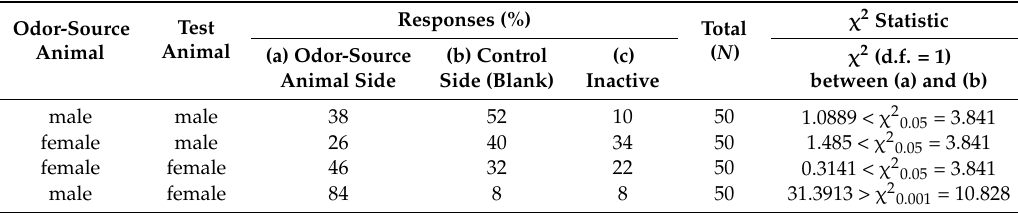
Table 3. Responses of male and female Rosalia batesi adults (test animals) to males or females (odor-source animals) as observed in the T-shaped olfactometer.